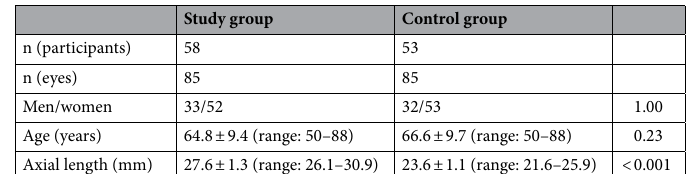
Table 1. Demographics of the study population.